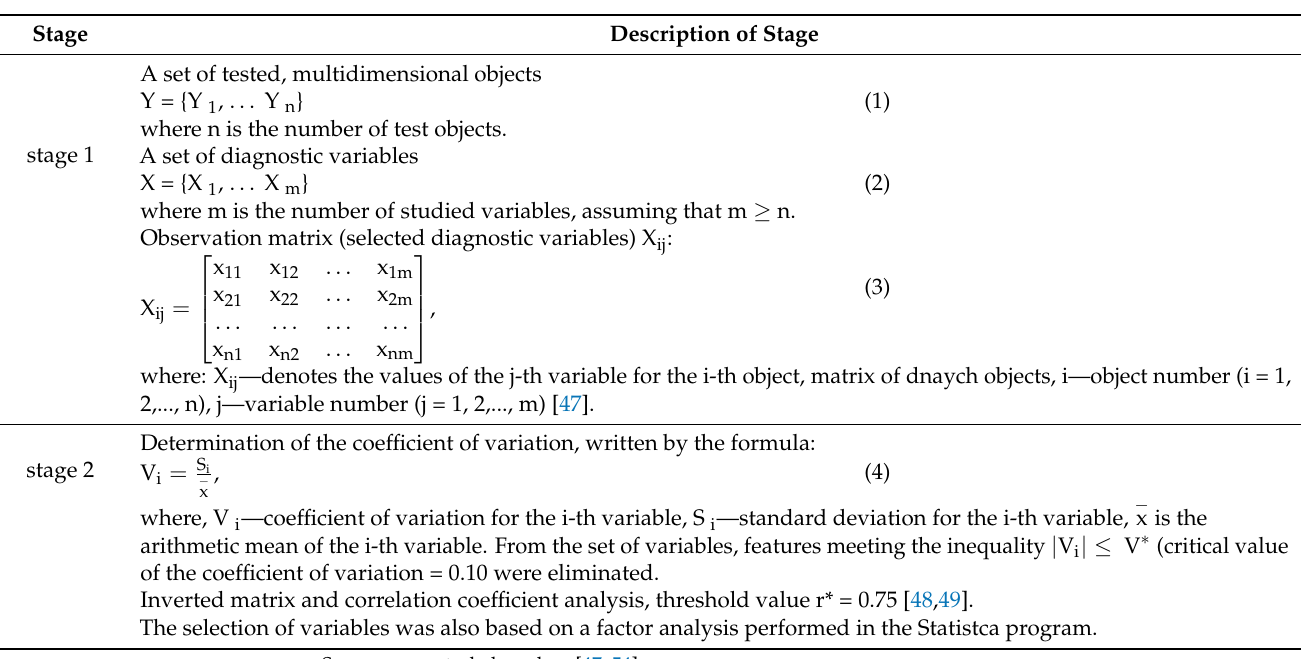
Table 1. Stages 1, and 2 of building a synthetic